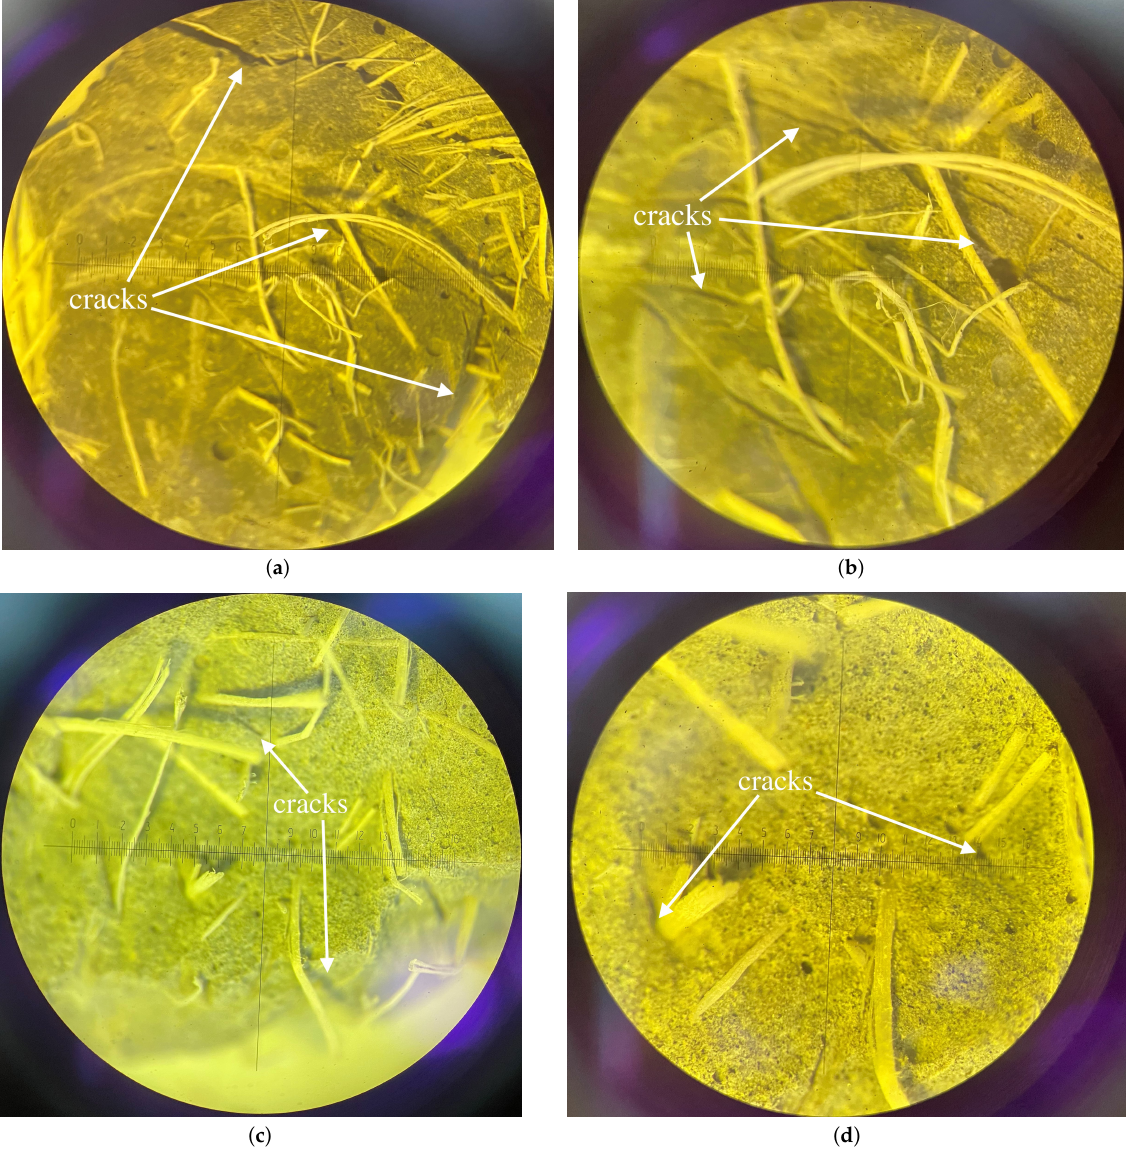
Figure 14. Photographs of the structure of concrete samples with a content of sisal fibers 1%: ( a ) with 4 × magnification; ( b ) with 6 × magnification; ( c ) with 8 × magnification; ( d ) with 10 ×